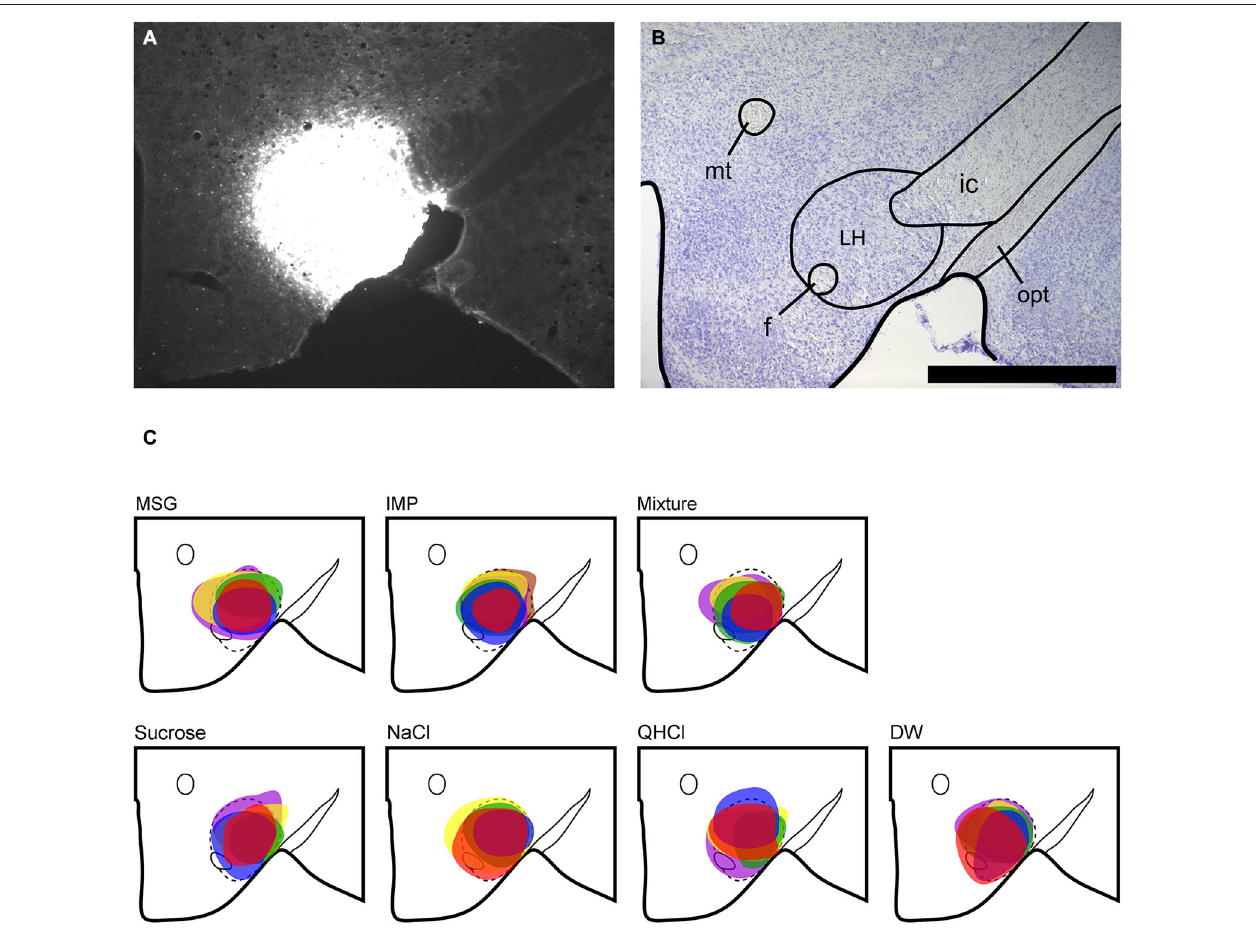
FIGURE 1 | LH injection sites. (A) Representative fluorescent image of FG injection site in the LH. (B) Nissl-stained section showing level of LH injection. (C) Plots of injection site and size (maximal extent) for each animal according to stimulus group; note that colors only identify separate animals within each stimulus subgroup, and do not convey any meaning across groups. Scale bar = 500 µ m. mt, mammillothalamic tract; f, fornix; ic, internal capsule; opt, optic